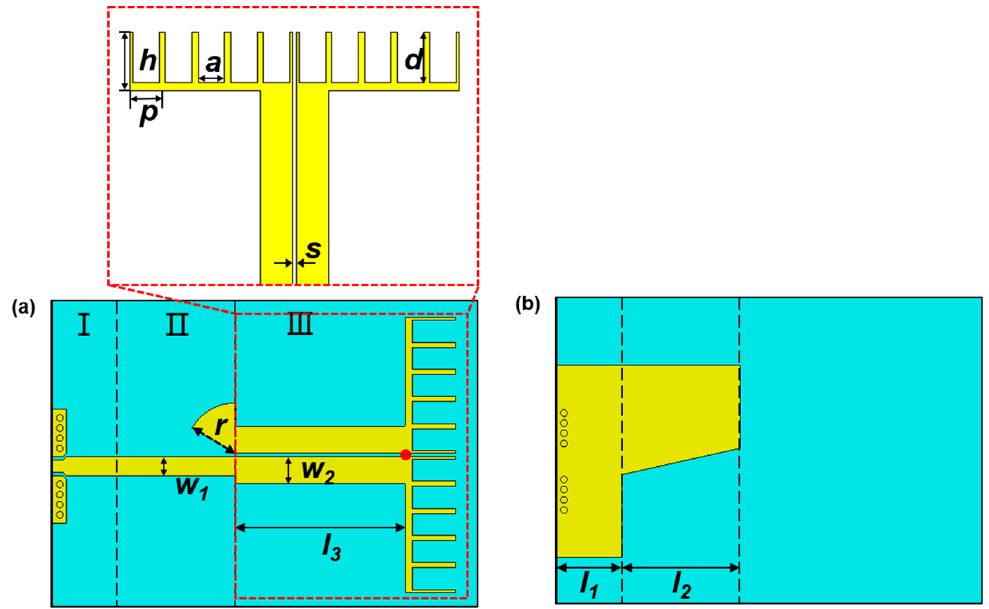
Figure 1. Top ( a ) and bottom ( b ) schematic diagrams of the proposed spoof plasmonic dipole antenna, where l 1 = 3.8 mm, l 2 = 7 mm, l 3 = 10 mm, w 1 = 1.14 mm, w 2 = 1.6 mm, r = 3 mm, s = 0.2 mm, p = 1.6 mm, h = 3 mm, a = 1.3 mm, d = 2.6 mm.